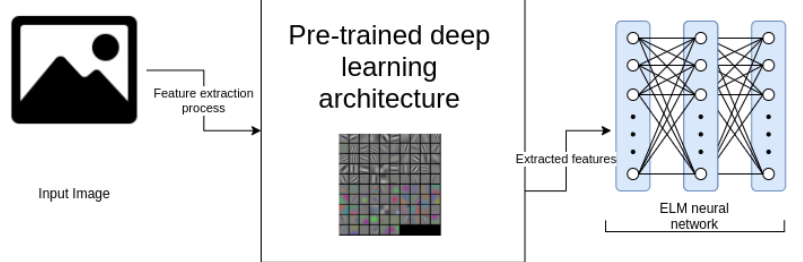
Figure 8. Example of the usage of pre-trained deep learning architectures and fine tuning with ELM.